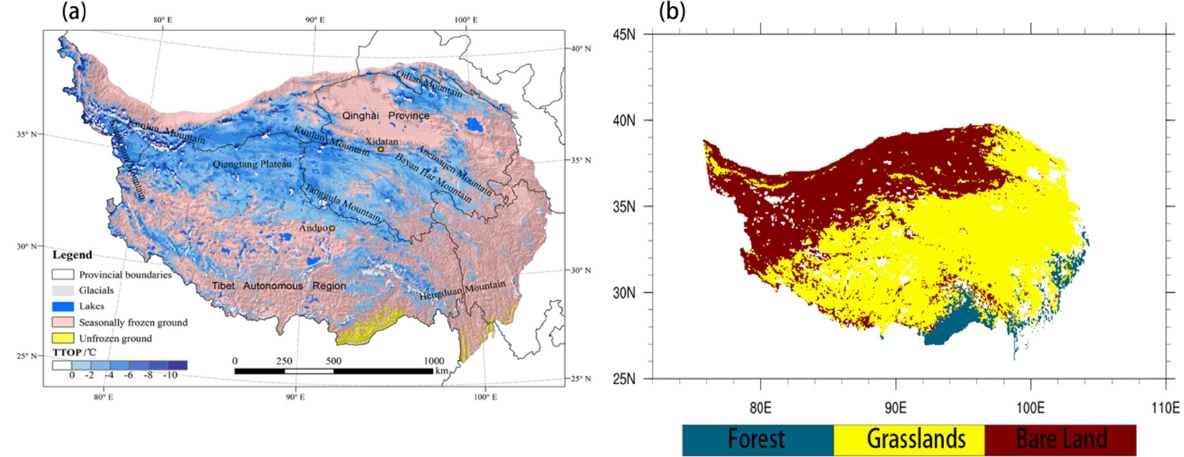
Figure 1. ( a ) Spatial distribution of permafrost on the TP [30]. ( b ) Spatial patterns of different vegetation types on the TP. The vegetation type map is derived from the MODIS land–cover product.